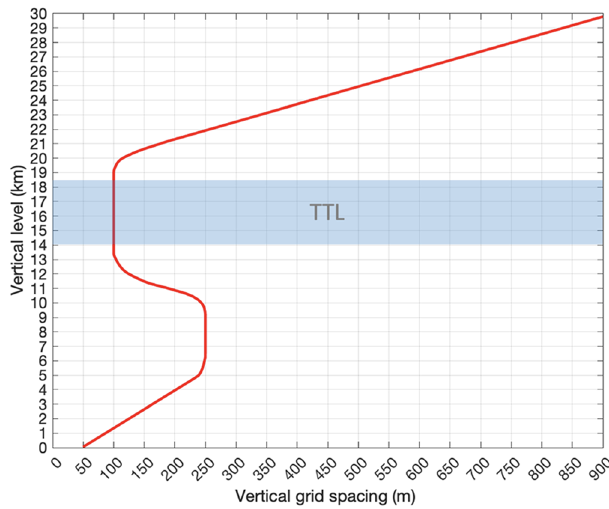
Figure 4. Vertical resolution as a function of model vertical level. The shaded blue area represents the